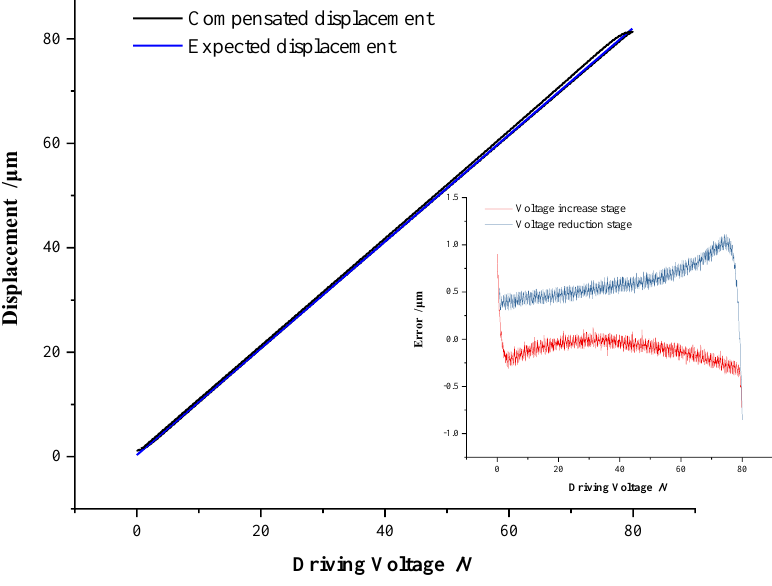
Figure 11. SMPI feed-forward compensation.